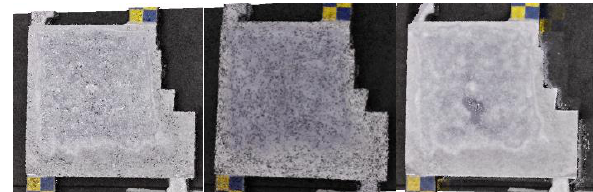
Figure 2.Examples of point cloud referred to nadiral (left), oblique (centre) and nadiral+oblique (right) images